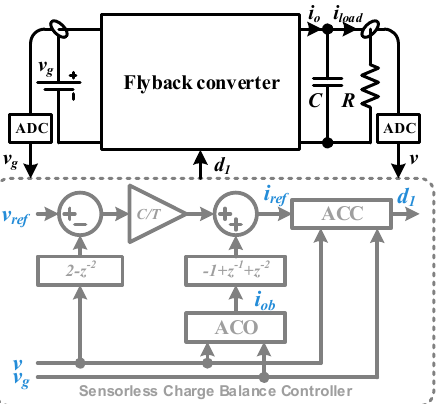
Figure 1. Flyback converter with sensorless charge balance controller.